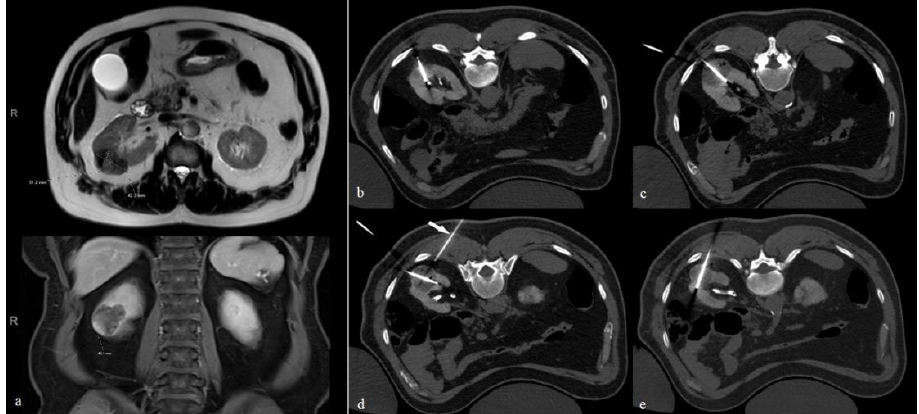
Figure 1. Cryoablation of a right renal RCC. ( a ) MRI scan shows a right renal partly exophytic mass, measuring 4.2 × 3.1 × 4.5 cm along the axial and craniocaudal dimensions, respectively. ( b – e ) Four cryoablation probes are carefully aligned along the longitudinal axis of the mass from cranial to caudal. In our experience, the orientation of the probe shown in figure ( e ) is critical as it allows the ice ball to ablate the most central part of the mass, which is a common site for recurrence. The arrow in ( d ) points to a 21 G needle used for CO 2 dissection, as shown in Figure 2.